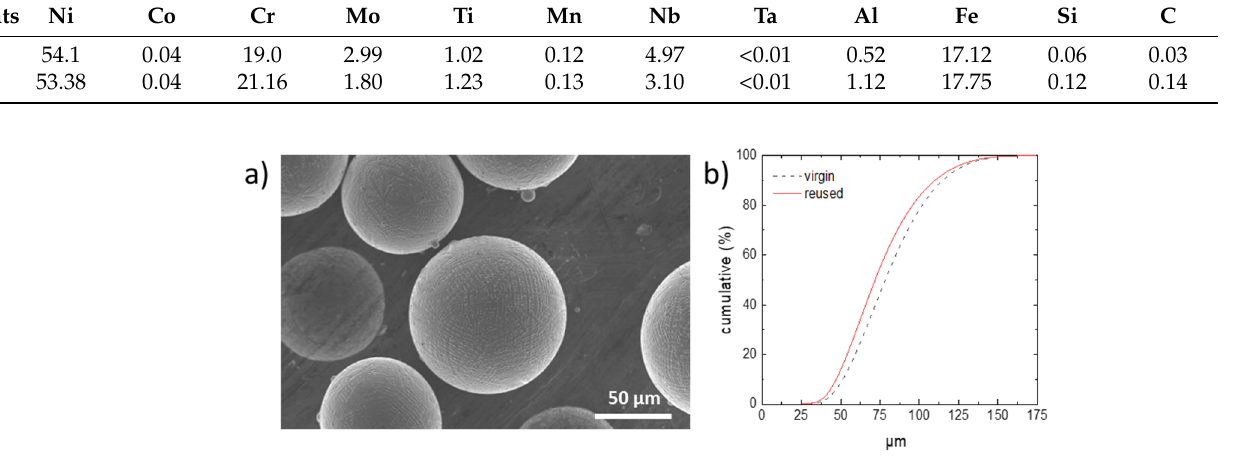
Figure 1. Inconel 718 powder ( a ) morphology of the virgin powder and ( b ) particle size distribution of virgin and reused powders.